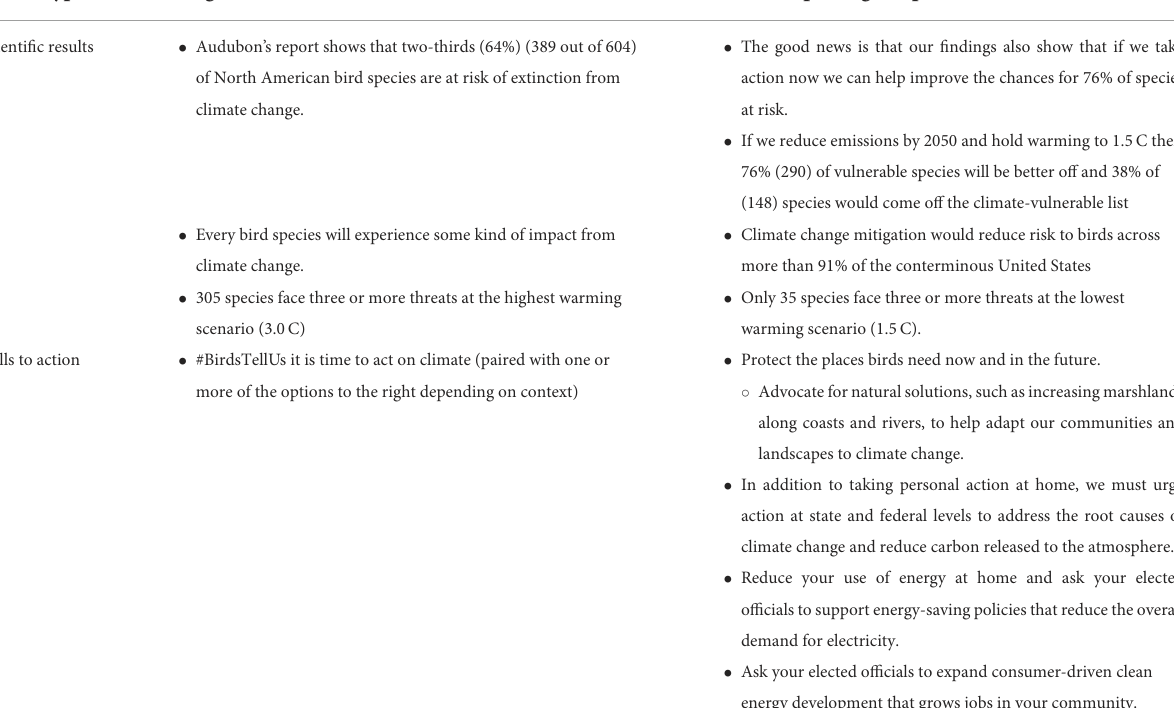
TABLE 1 Communications framework used for public rollout of the Survival by Degrees: 389 Birds on the Brink